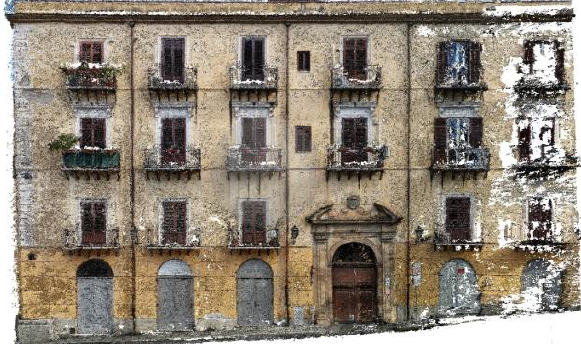
Figure 7: SfM reconstruction using Super- Resolution image of the façade of the ancient building. Dense Cloud.